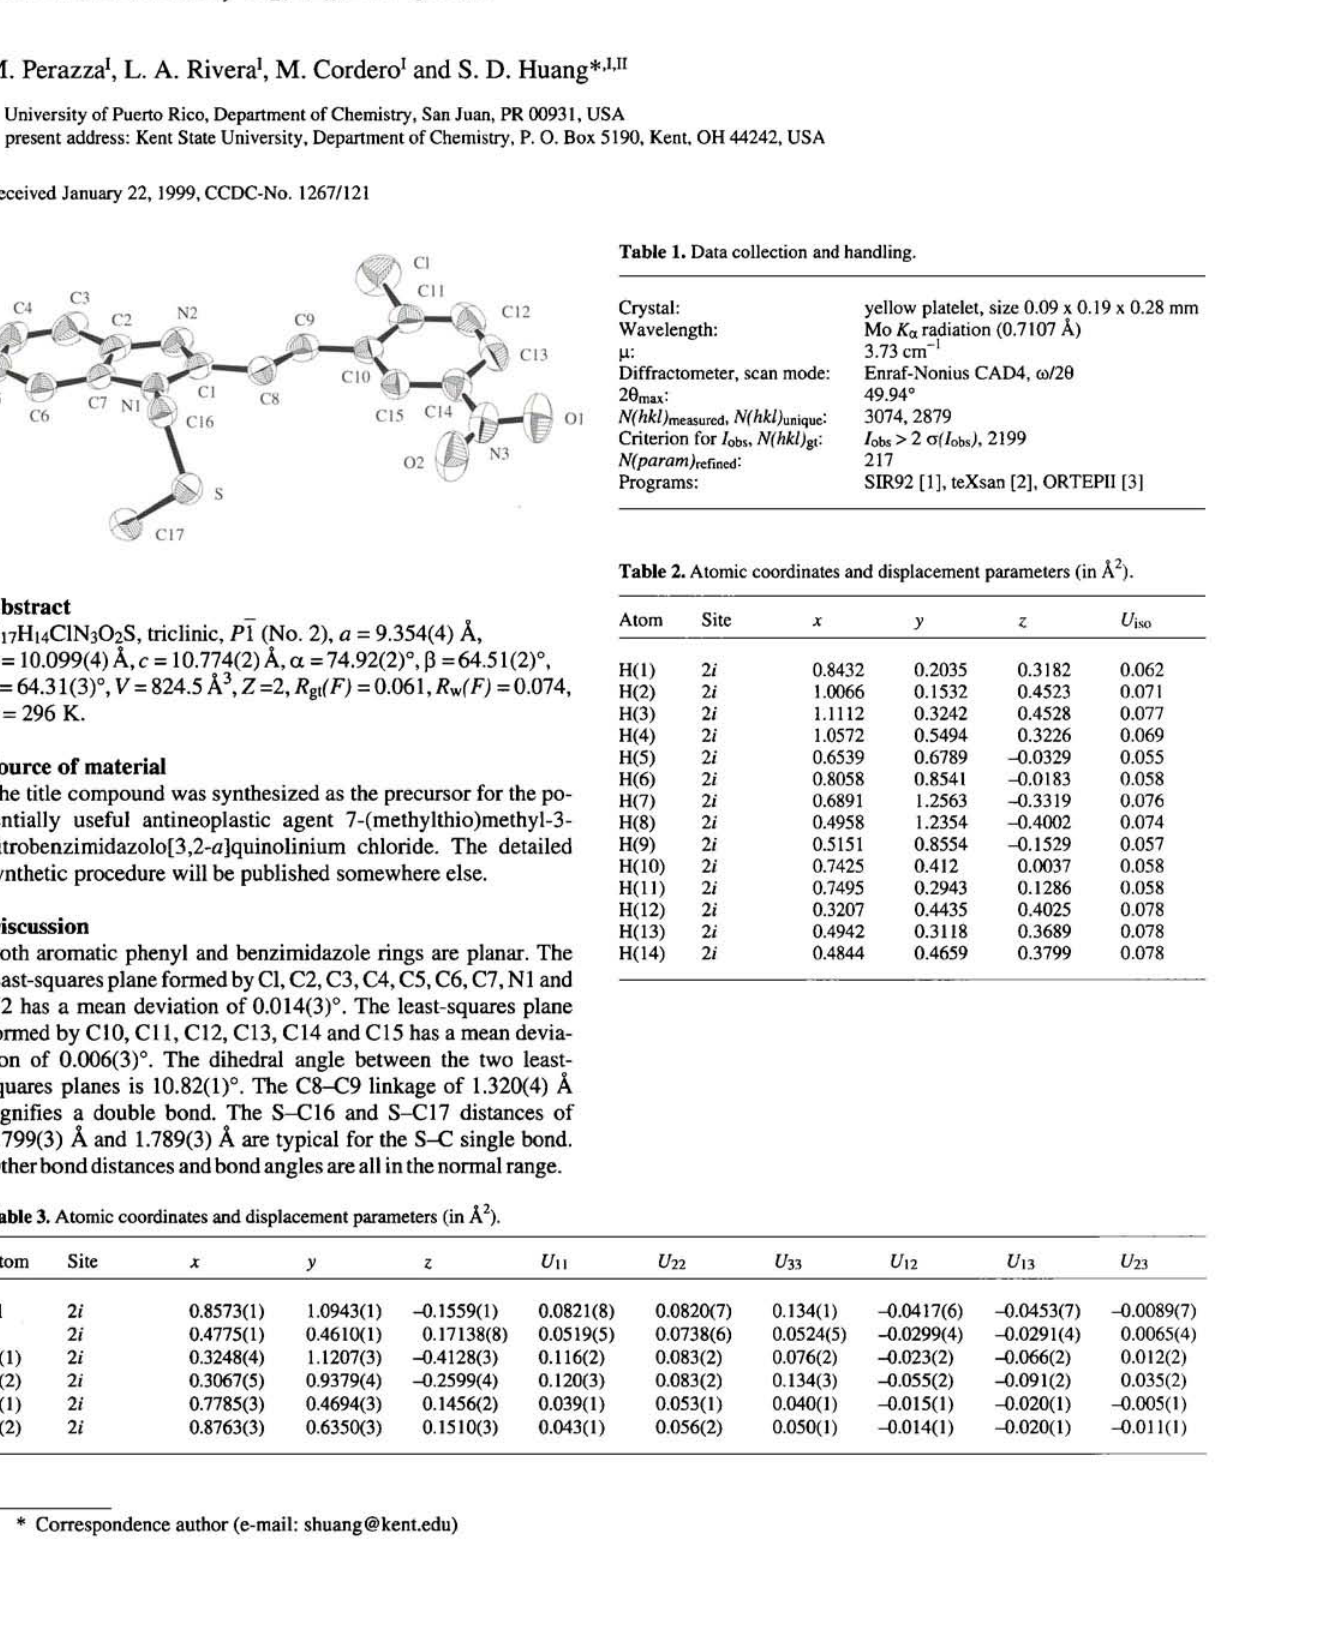
Table 1. Data collection and handling.